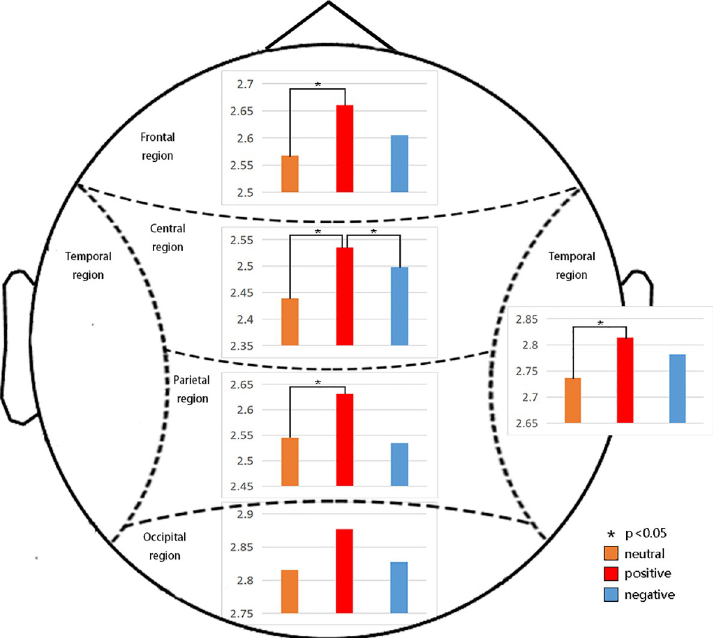
Fig 9. Significant differences in different brain regions under VR-2D or VR-3D modes for the α band. The emotion effect in the VR-3D group was large, and positive emotions (P = 0.03 < 0.05) were significantly higher than neutral and negative